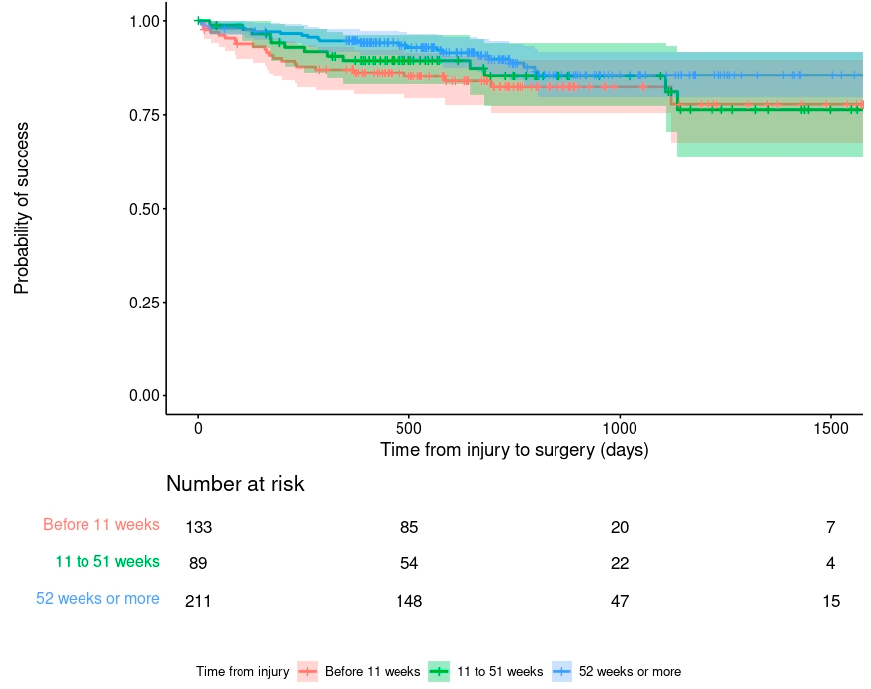
Figure 1. Kaplan–Meier survivorship curve demonstrating the relationship between time from injury to FRI surgery and the primary outcome.